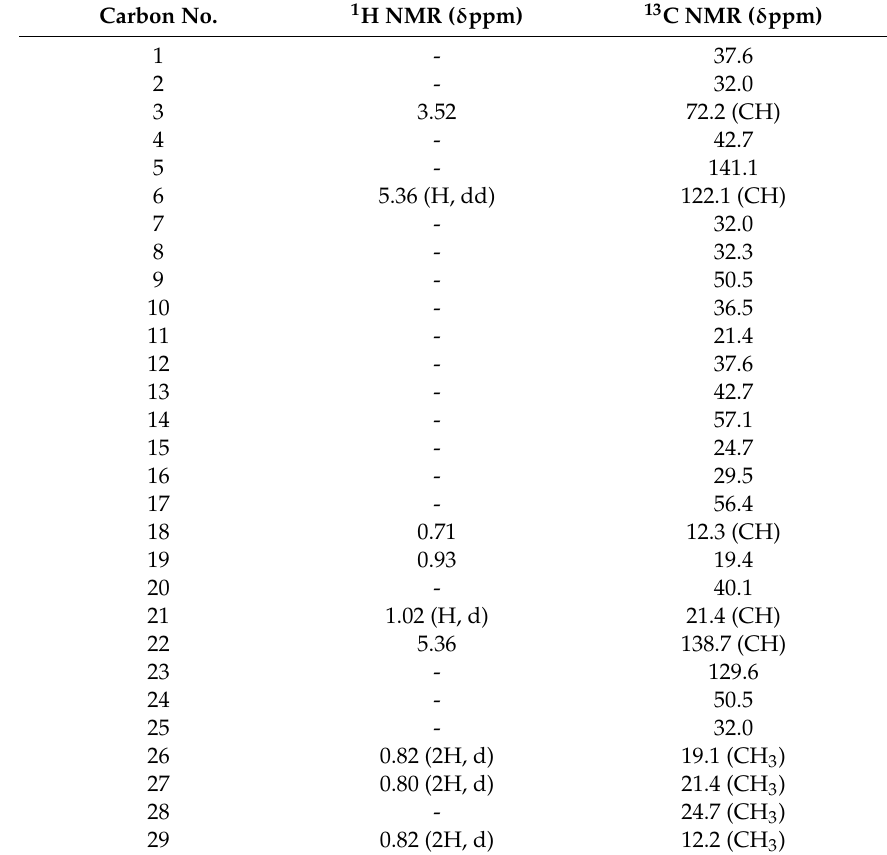
Table 2. The 1 H and 13 C NMR spectral data (recorded in CD 3 OD) of BV2 fraction isolated from Bauhinia variegata L.